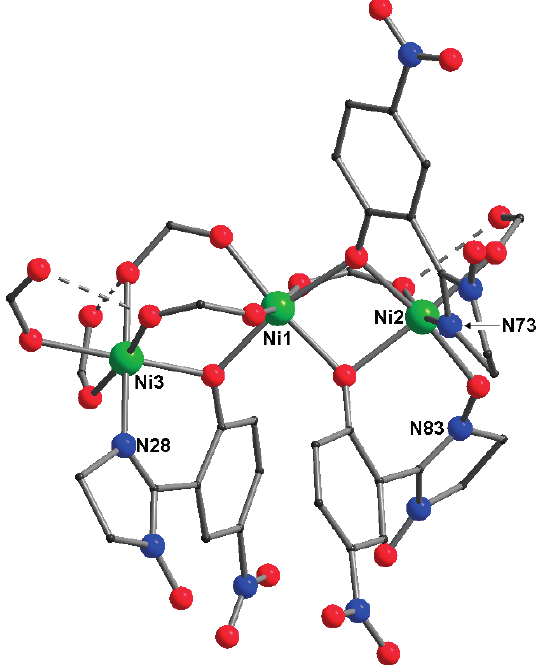
Figure 3. Molecular structure of [Ni 3 L 1 L 2 2 (Piv) 3 (HPiv) 3